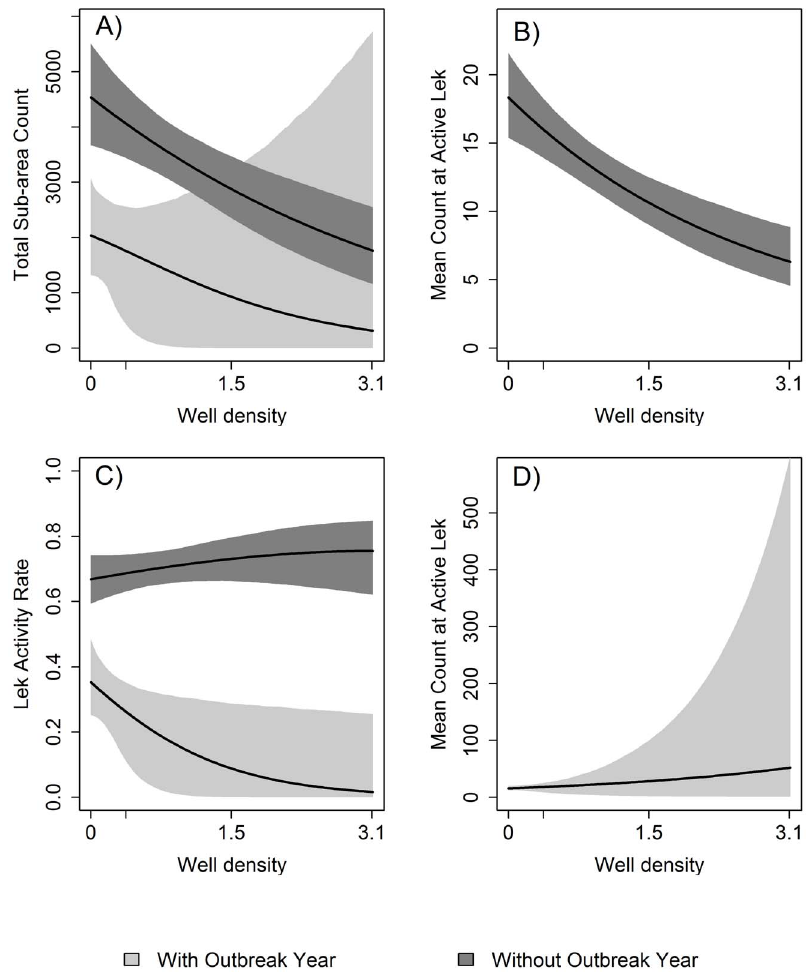
Figure 2. Predictions for Northeast Wyoming sage-grouse. Lines show expected values, and shaded areas are 95% confidence regions. Oil and gas well density is given in # wells/km 2 within a 20 km radius of each lek. A) Total count of male sage-grouse on all leks in northeast Wyoming, B) Mean count of male sage-grouse at active leks absent a WNv outbreak year, C) Proportion of leks that are active, and D) Mean count of male sage- grouse at active leks subsequent to a WNv outbreak year. Note difference in scale of y-axis between B and D.